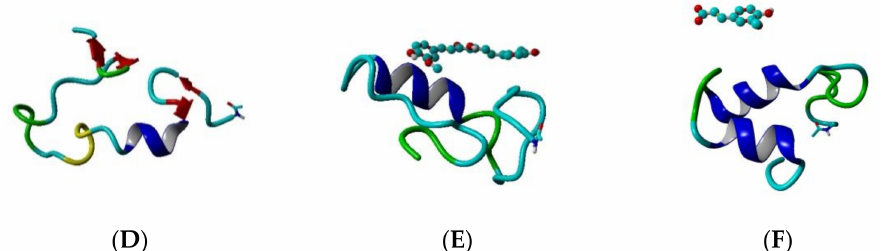
Figure 3. Topologies of the modelled systems at the beginning (frame #1) and at the end (frame #100,000) of the production phase: ( A ) A β peptide at frame #1, ( B ) A β peptide and CU at frame #1, ( C ) A β peptide and FA at frame #1, ( D ) A β peptide at frame #100,000, ( E ) A β peptide and CU at frame #100,000, ( F ) A β peptide and FA at frame #100,000. The peptide is given in cartoon, the